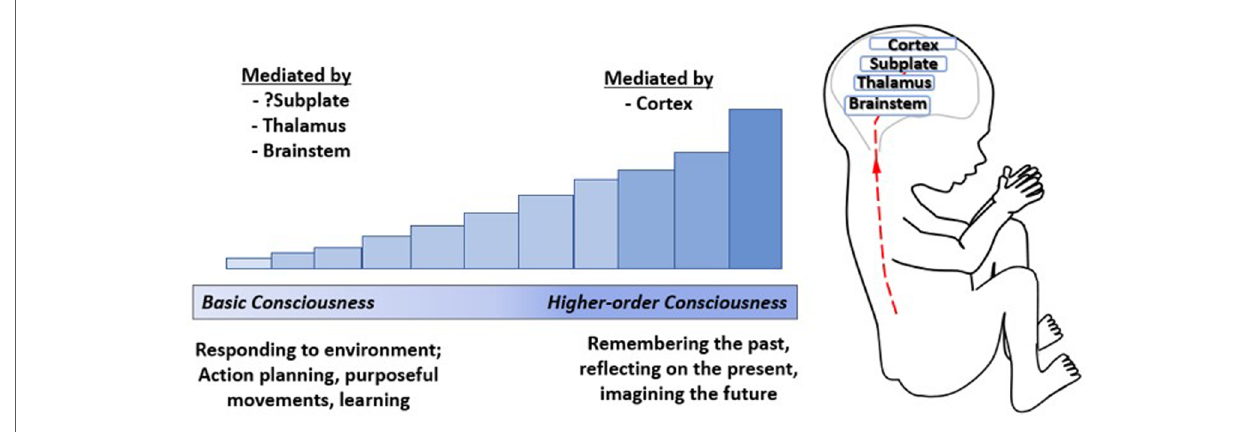
FIGURE 9 The emergence of consciousness. Consciousness has been likened to a dimmer switch beginning with a minimum basic level of consciousness mediated by the brainstem (100), thalamus (99), and possibly the cortical subplate (4) increasing to higher-order consciousness mediated by the cortex (100). Basic consciousness requires responsiveness to the environment (101), demonstrated by action planning, purposeful movements, and leaming (100), while higher-order consciousness involves memory, self-re fl ection, and imagining the future